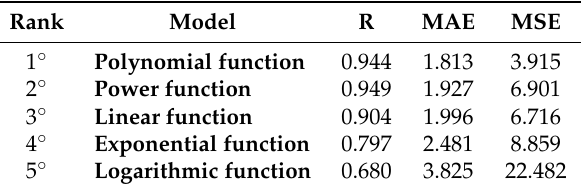
Table 5. Effective functions for forecasting harvested